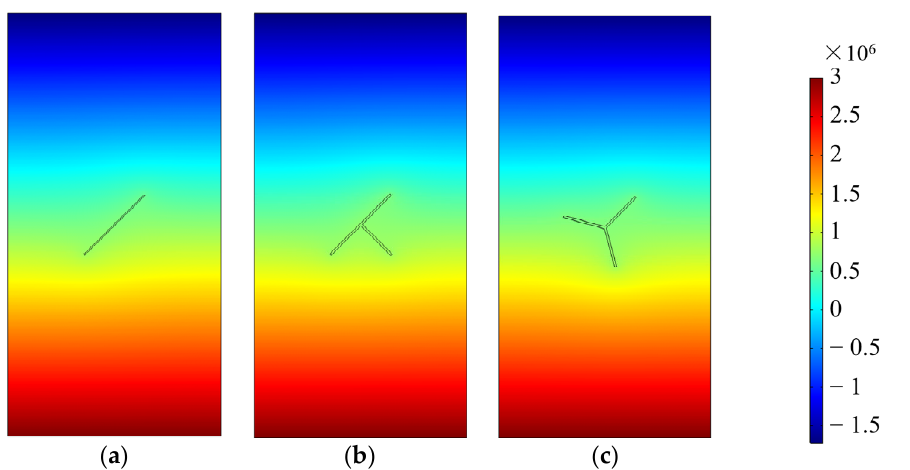
Figure 12. Seepage pressure distribution map of the sample: ( a ) Single fracture; ( b ) T ‐ shaped fracture; ( c ) Y ‐ shaped fracture.